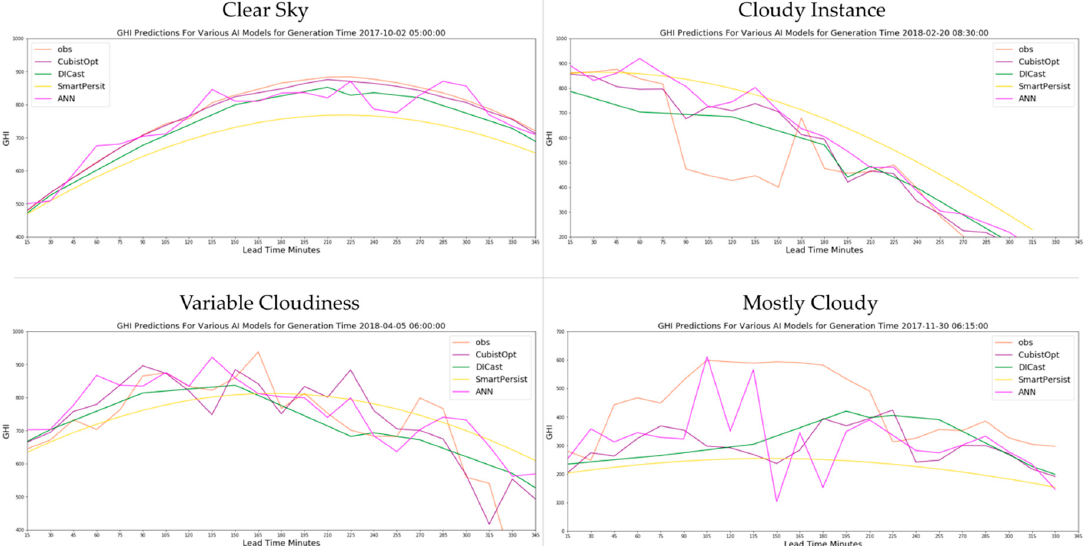
Figure 7. Comparison of the CubistOpt, DICast, Smart Persistence, and ANN models compared to observations (orange line) for a clear sky day (Figure 7: top left ), one cloud for one hour (90 min–150 min) during the forecast time period ( top right ), a variable cloudiness day ( bottom left ), and a mostly cloudy day ( bottom right ).